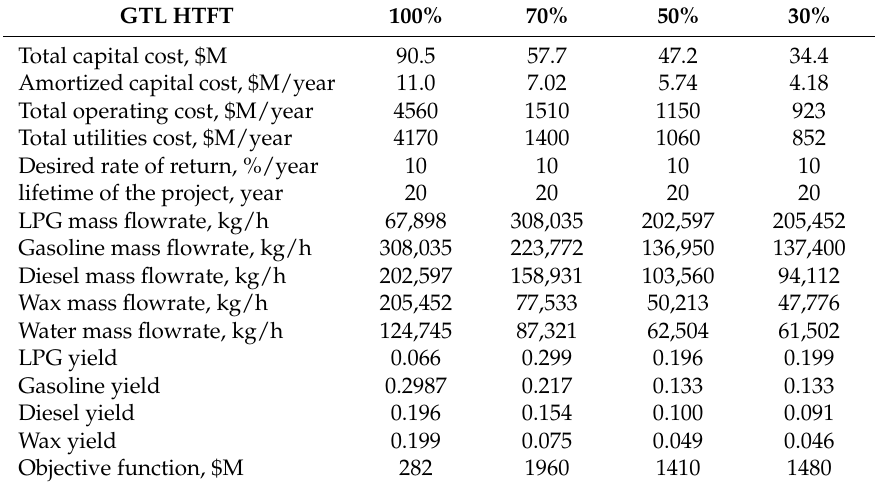
Table 7. GTL (HTFT) production results for different methane feedstock utilization